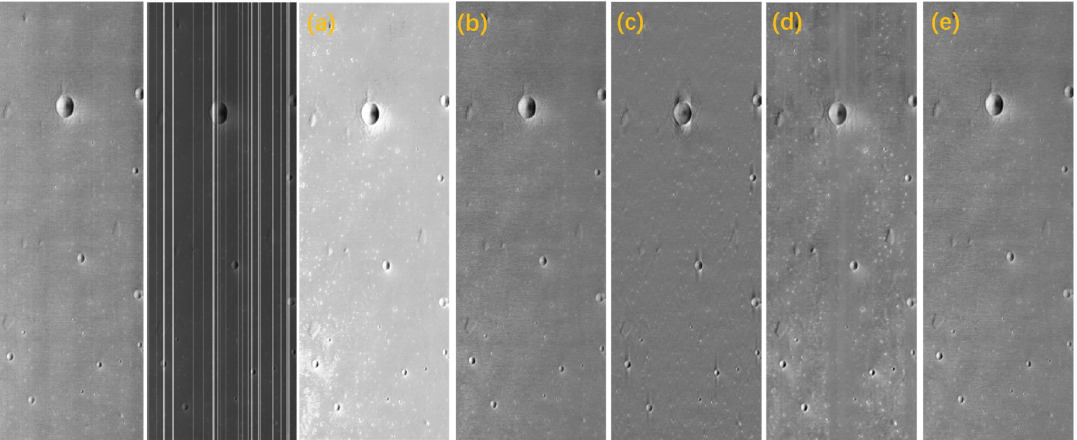
Figure 11. Correction results for the MMS V-NIR (central wavelength of 950.9 nm) simulation data from linear stretched images. Original V-NIR image (left) and an image with strip noise (second from the left). Correction results based on the different algorithms for the simulated images shown: ( a ) HM, ( b ) MM, ( c ) BW, ( d ) TV, and ( e ) the proposed